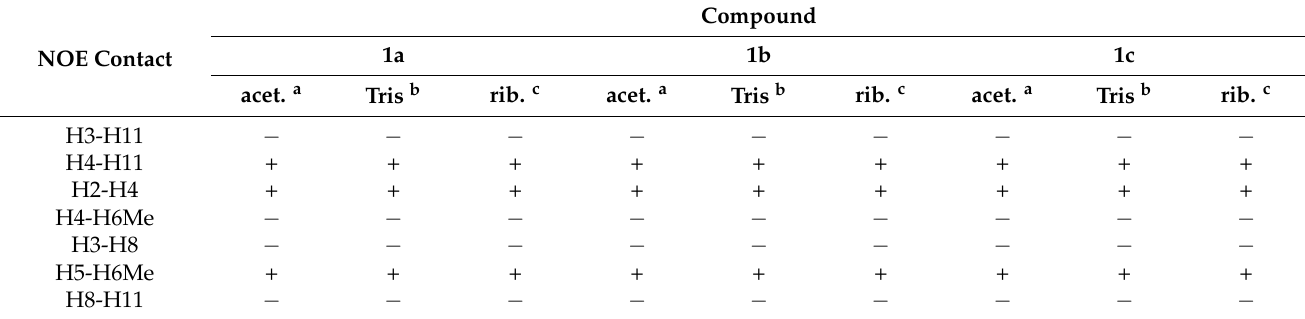
Table 3. Characteristic NOE contacts for 1a–c in free and bound states.